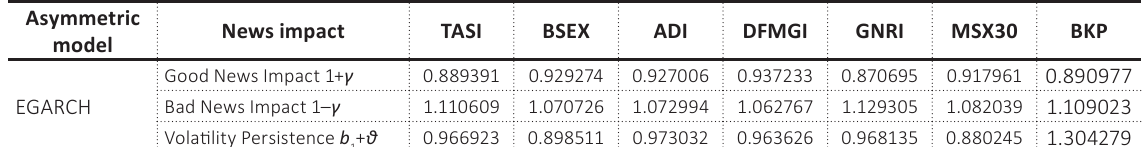
Table 9. News impact and volatility persistence